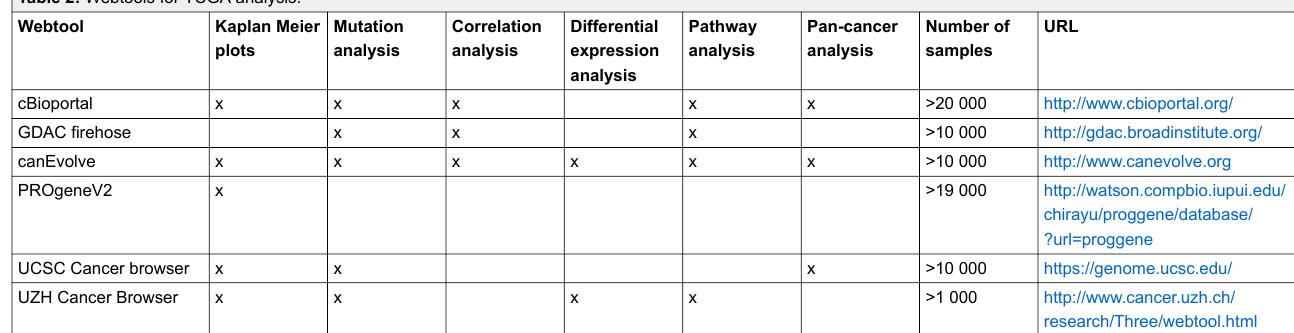
Table 2: Webtools for TCGA analysis. Webtool Kaplan Meier